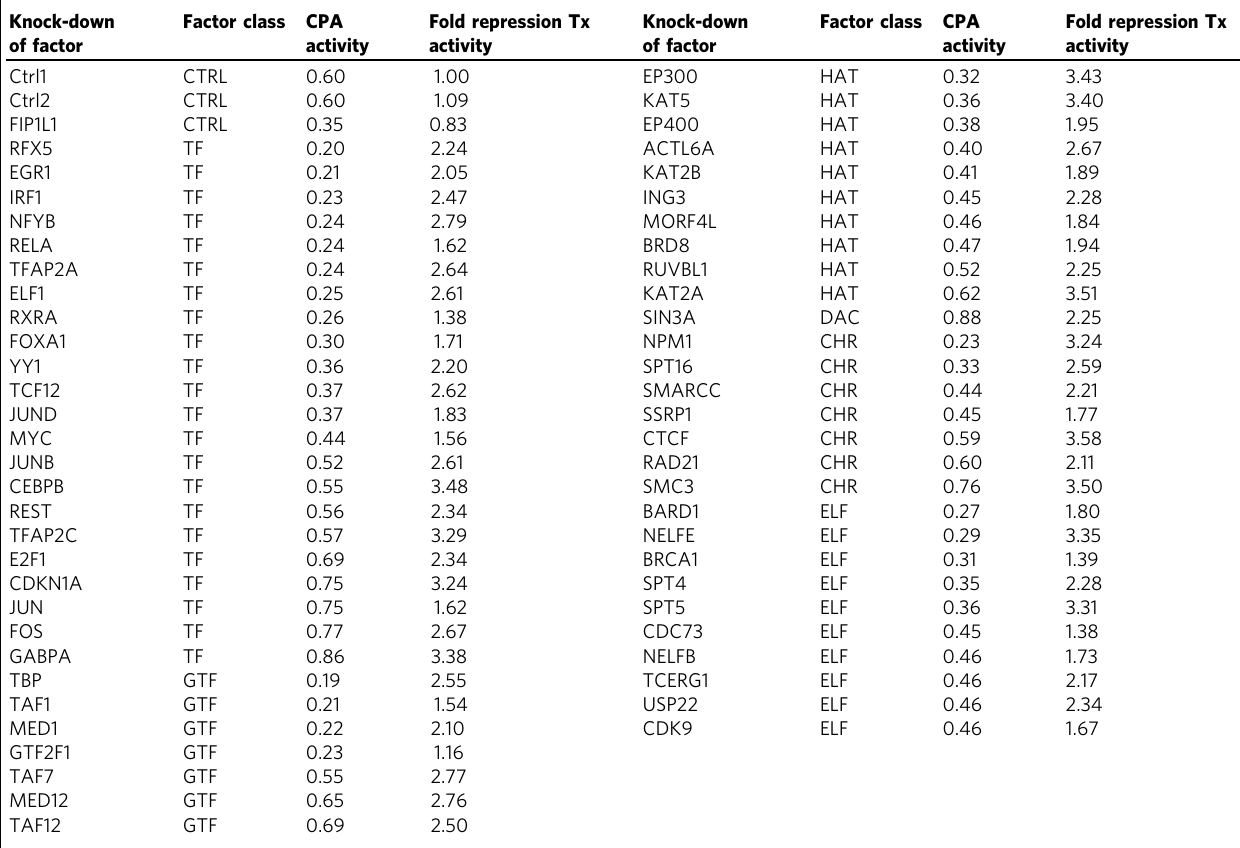
Table 1 Transcription factors and co-activators that regulate CPA activity of the proximal PAS of PTEN. Knock-down of